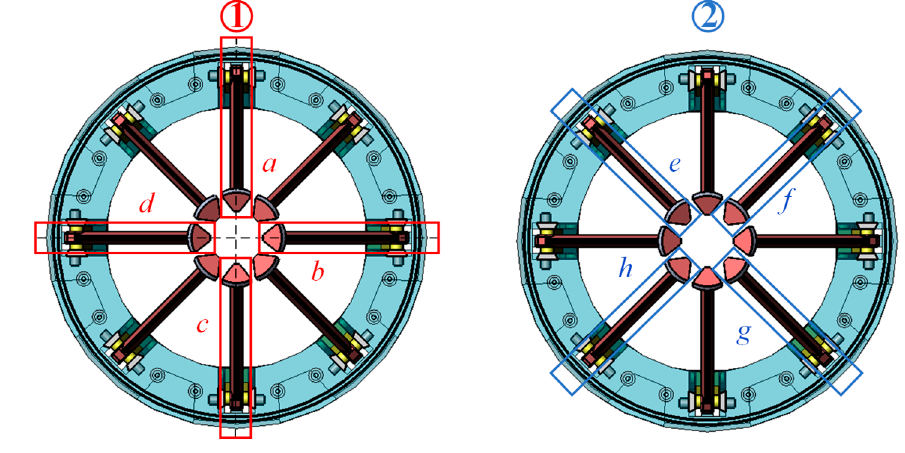
Figure 6. Active capture arm grouping.